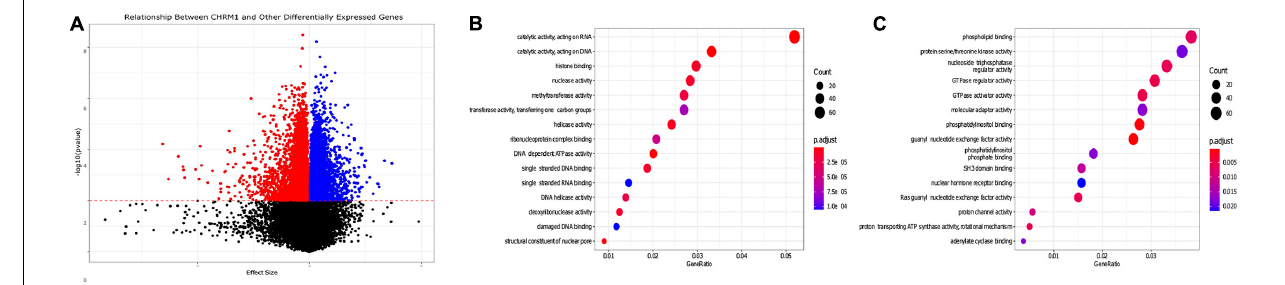
FIGURE 4 | Gene pathways differentially expressed in colon adenocarcinomas associated with changes in CHRM1 expression levels. (A) We used a series of univariate mixed models (participant ID as random effect) to assess the relationship between expression levels of CHRM1 and other genes in the dataset, with 4,724 genes demonstrating statistically significant ( p -value ≤ 0.01) negative associations and 4,463 demonstrating significant positive associations with CHRM1 . (B) We detected 3,921 genes that had a model with a surrogate effect magnitude ≥ 0.25 with KEGG data available. Seventy-seven GO terms were upregulated in adenocarcinoma samples—the top 10 are displayed. (C) Twenty-five GO terms were downregulated in adenocarcinoma samples.